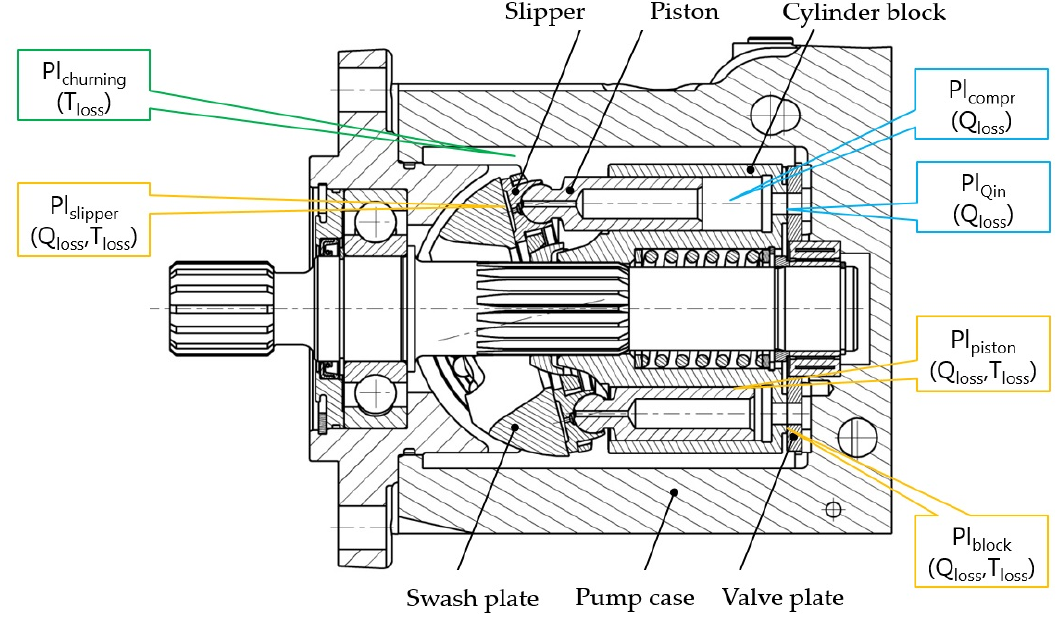
Figure 1. Power losses in an S-APP.